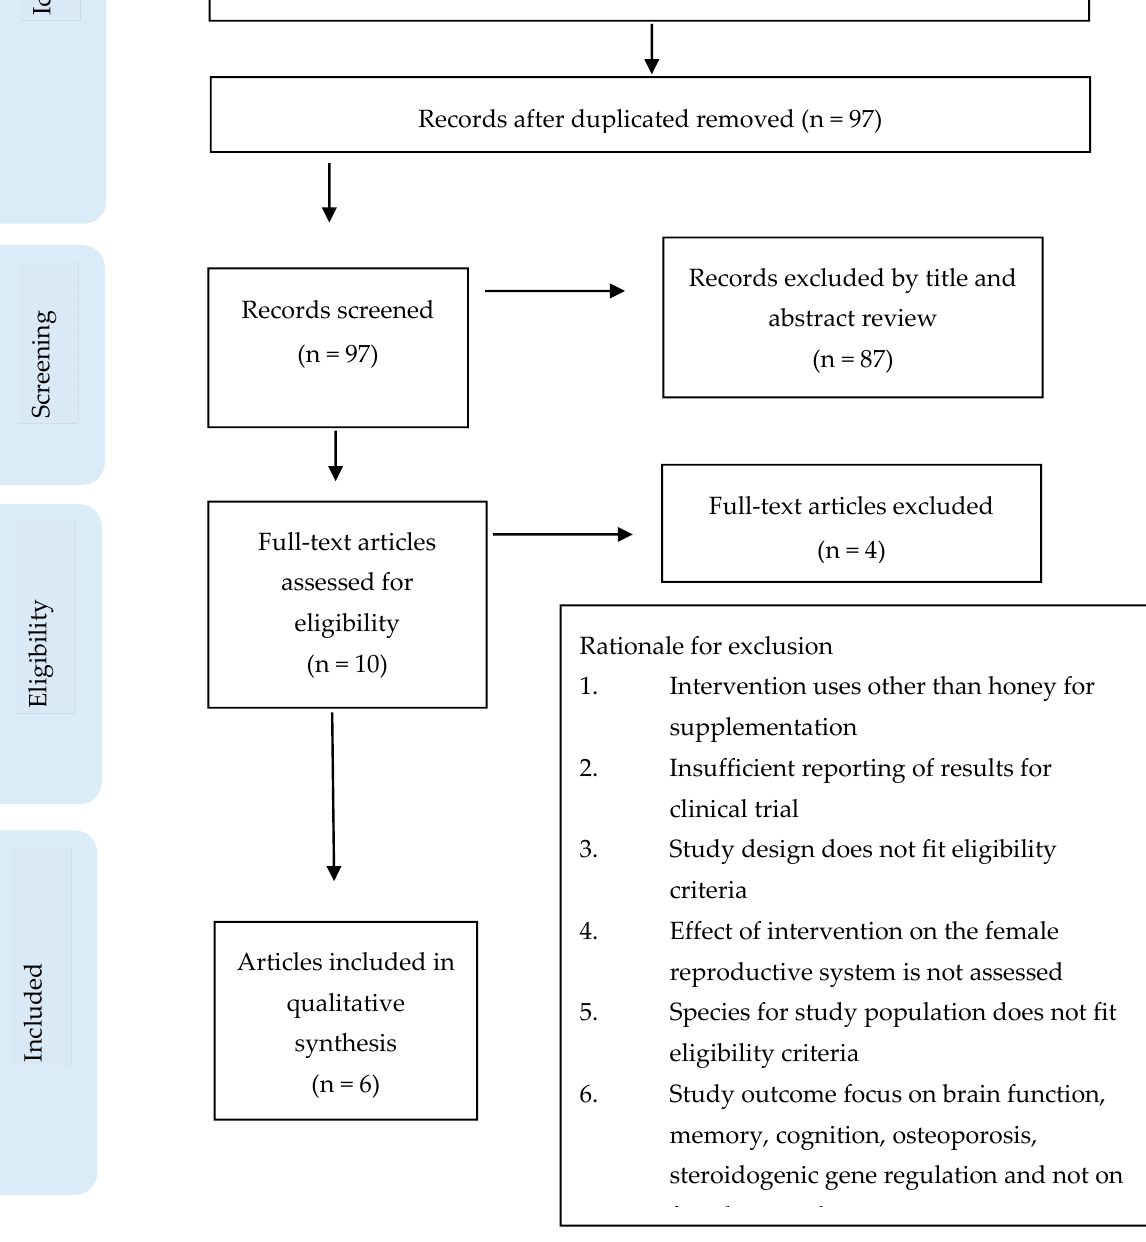
Figure 1. Flow chart of the article selection process from Scopus, MEDLINE via Ovid and Cochrane databases.